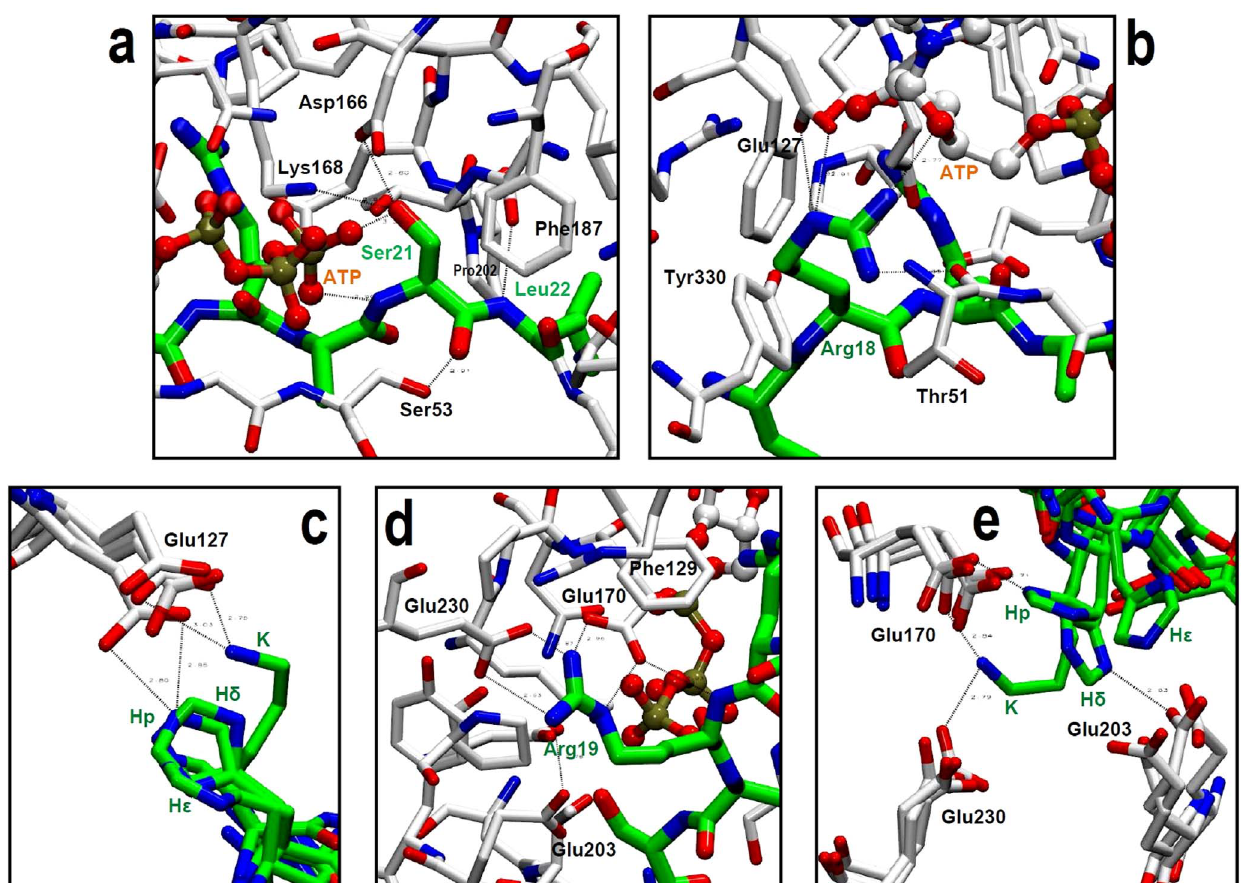
Figure 5. PKA-substrate HB interactions observed in MD simulations for the complexes containing WT and mutant peptides. (A) Interactions of substrate Ser21 and Leu22. (B) Interactions of substrate Arg18. (C) Interactions of Lys and histidines at position 18 of the substrate. (D) Interactions of substrate Arg19. (E) Interactions of Lys and histidines at position 19 of the substrate. doi:10.1371/journal.pone.0109639.g005 contribute to the real system. The better contribution to the of the substrate when they interact with PKA active site. We correlation of one of the histidines should indicate which is the evaluated the correlations for the mutants when different pairs of preponderant protonation state of histidine at positions 18 and 19 classical histidines are incorporated. It is noteworthy that there is a